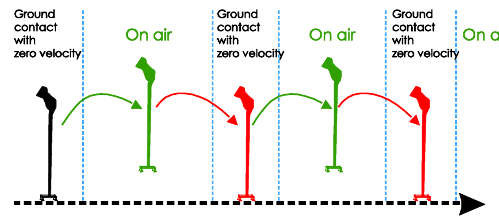
Figure 6. Quadripod cane’s movement patterns.